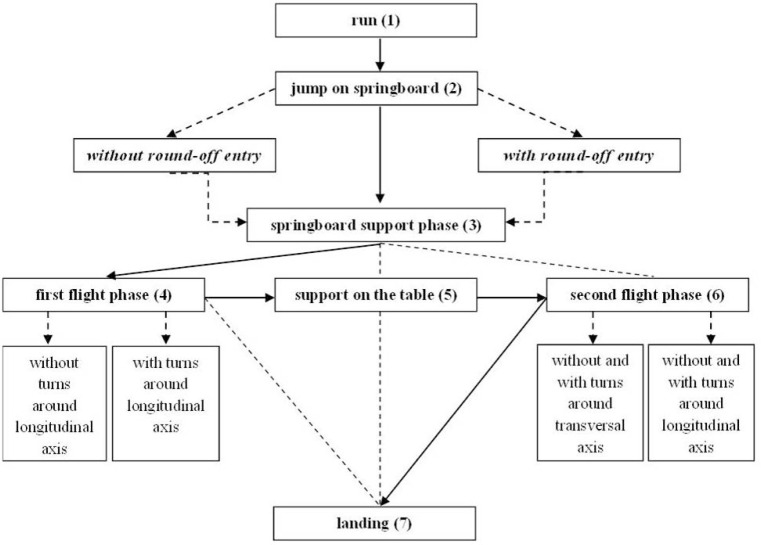
Schematic presentation of a possible jump to the vault (Prassas, 2002; 2006; Čuk, Karácsony, 2004; Takei, 2007; Ferkolj, 2010, Atiković and Smajlović, 2011)